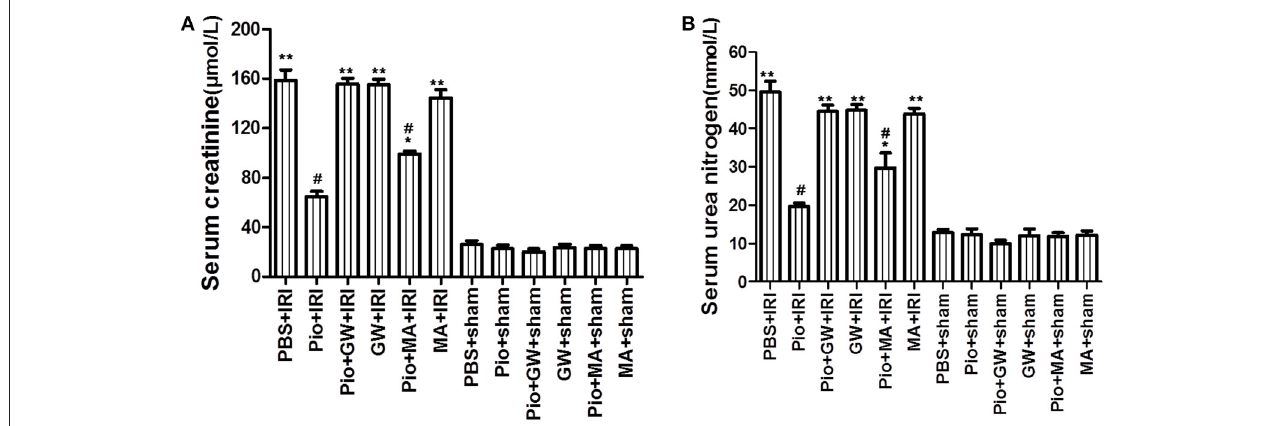
FIGURE 1 | Pioglitazone protects against renal IRI. (A) Serum creatinine in different groups at 24h after renal IRI. (B) Serum urea nitrogen in different groups at 24h after renal IRI. Data shown are means ± SE. Compared with the PBS + sham group, * P < 0.05, ** P < 0.01. Compared with the PBS + IRI group, # P < 0.05. n = 10 in each group.